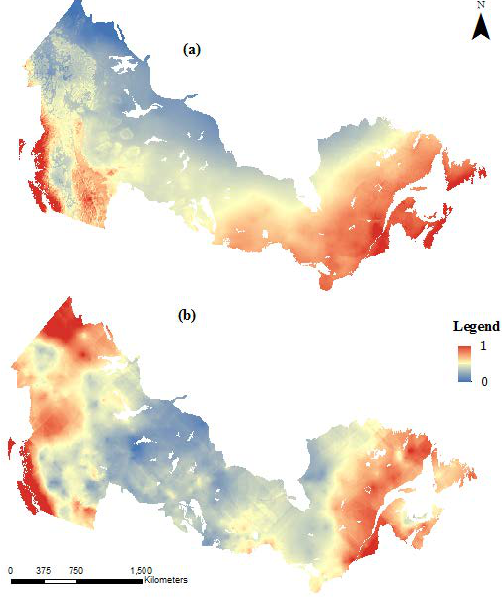
Figure 13. (a) Predictive SOC distribution (1961-1991) estimated from spatial error model parameters. (b) Interpolated